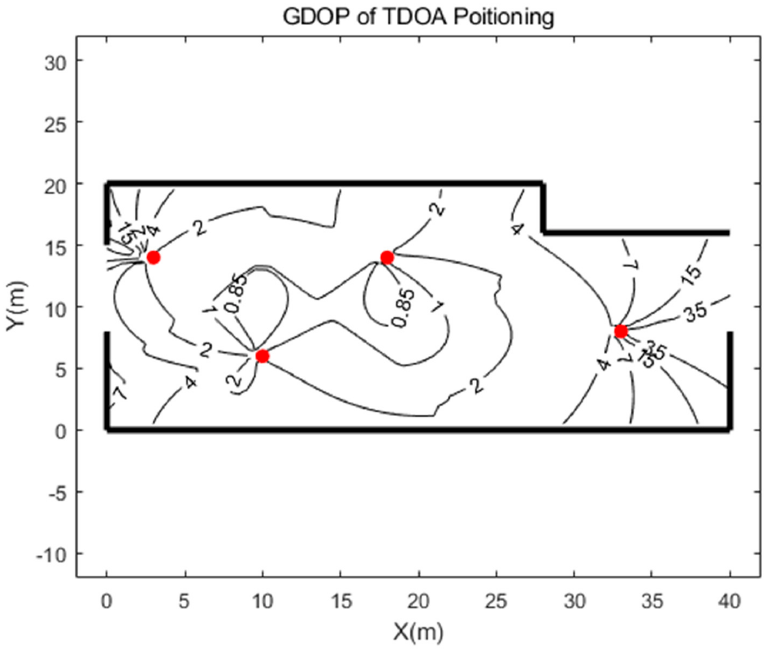
Figure 6. GDOP of TDOA positioning in the developed indoor 2D simulation scenario. The red dots are ANTs.